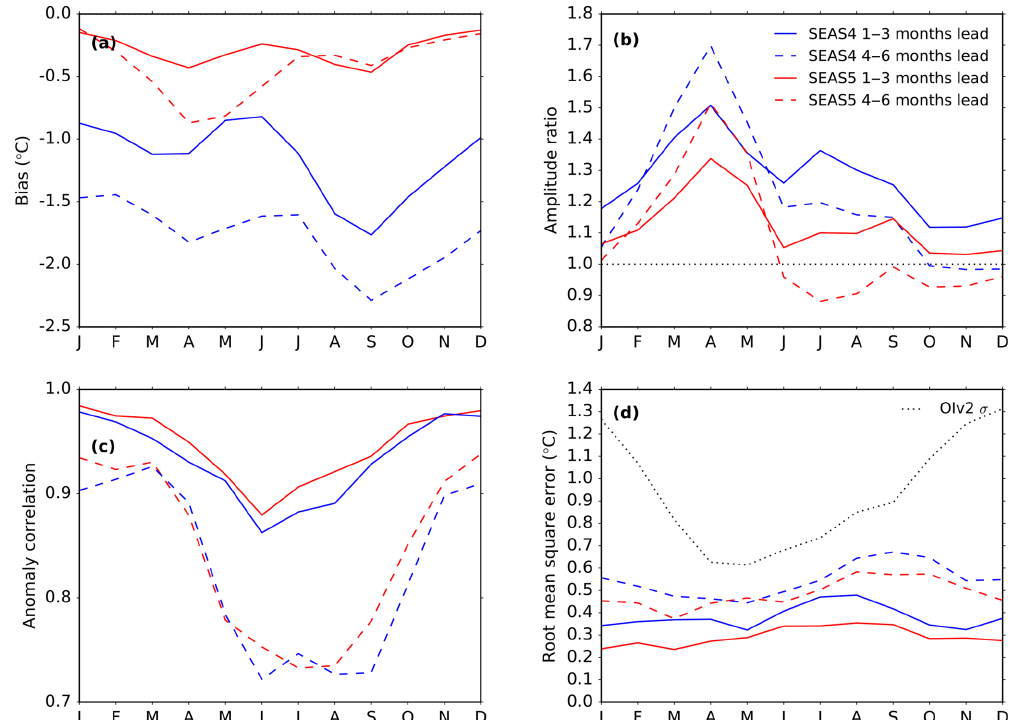
Figure 3. Forecast performance metrics of the monthly averaged Niño 3.4 index in SEAS4 (blue) and SEAS5 (red) as a function of verifi- cation month. The solid lines are averaged over 1 to 3 months lead times, and the dashed lines are averaged over 4 to 6 months lead times. Each line uses 15 ensemble members. The top row shows (a) Niño 3.4 SST climatological bias and (b) ratio of the standard deviation of the re-forecast and OIv2 anomalies, calculated using the individual ensemble members. The bottom row shows (c) anomaly correlation and (d) RMSE. The standard deviation of the inter-annual variability in OIv2, indicating the annual cycle of the inter-annual variability, is plotted as the dotted line in panel (d)